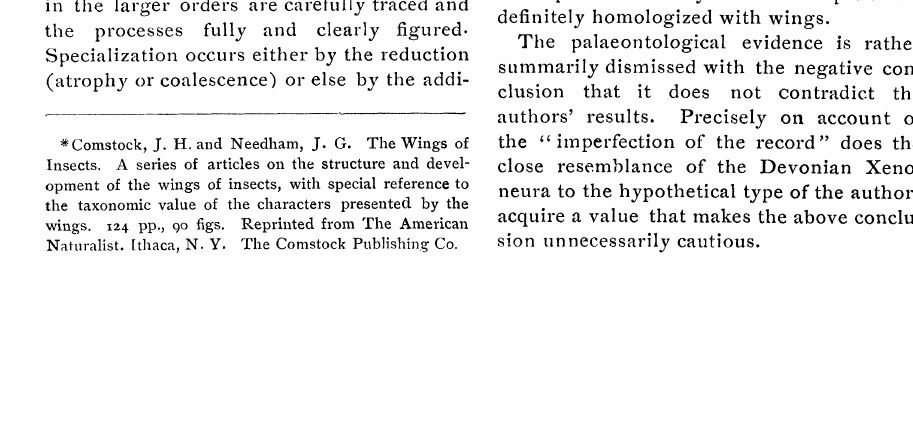
figs. Reprinted from The American Naturalist. ithaca, N.Y. The Comstock Publishing Co.